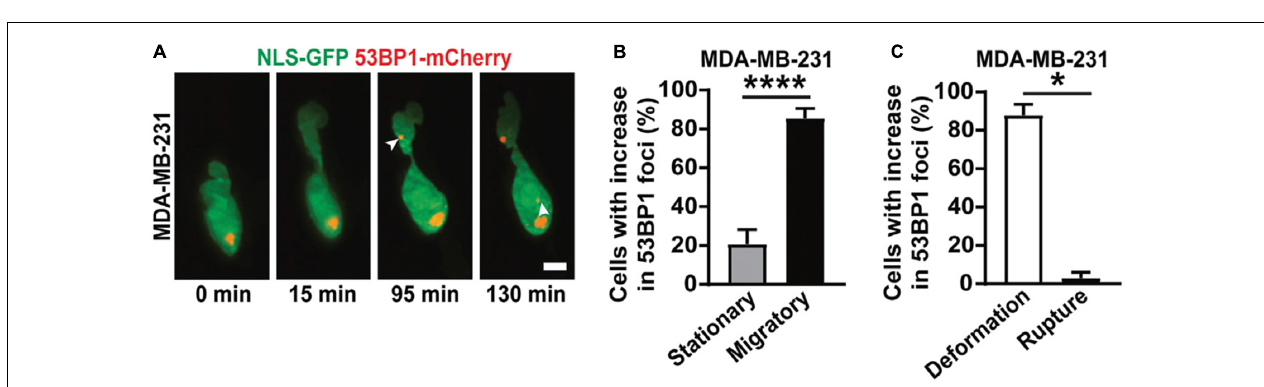
FIGURE 5 | 3D LSFM combined with confined migration minimizes photodamage during force-based experiments. (A) LSFM images of an MDA-MB-231 cell expressing GFP-tagged nuclear localization sequence (NLS-GFP), in green, and DNA damage marker (53BP1-mCherry), in red, navigating a 3D collagen matrix. The white arrows indicate new sites of DNA damage. Scale bar: 5 µ m. (B) The percentage of MDA-MB-231 nuclei that show new sites of DNA damage when stationary or migratory. **** represents p < 0.0001 for a Fisher’s test. (C) The percentage of MDA-MB-231 nuclei that show DNA damage due to deformation alone or due to nuclear rupture. * represents p < 0.05 for a chi-square test. Images are reproduced with permission from Shah et al.